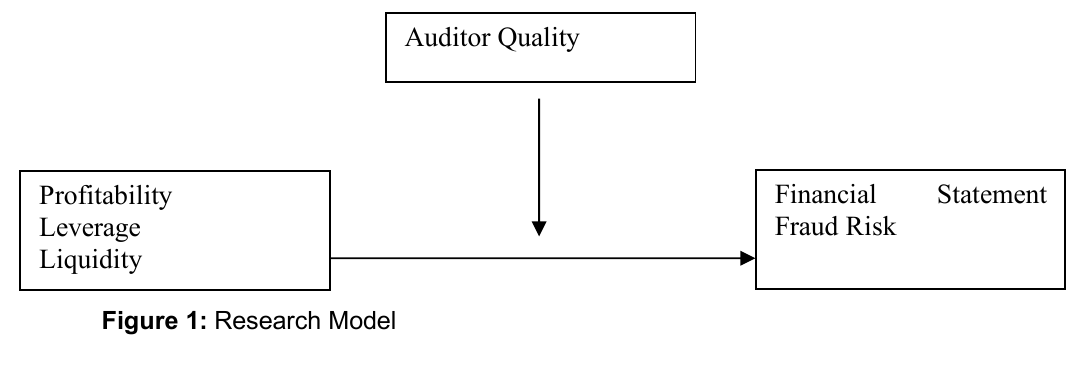
Figure 1: Research